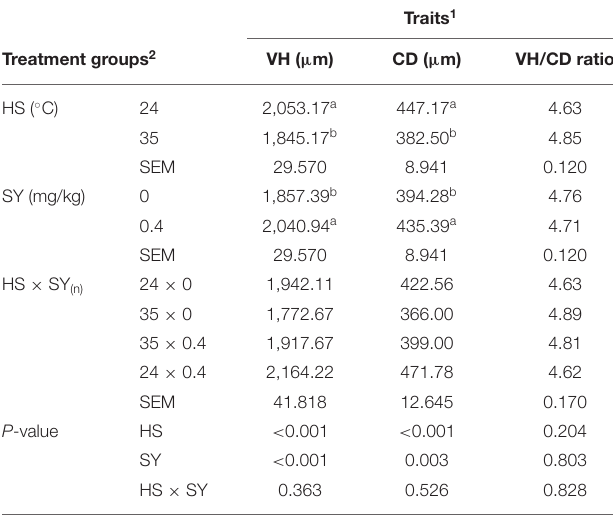
TABLE 5 | Effect of dietary organic selenium supplementation on the intestinal histomorphology of laying hens under heat stress